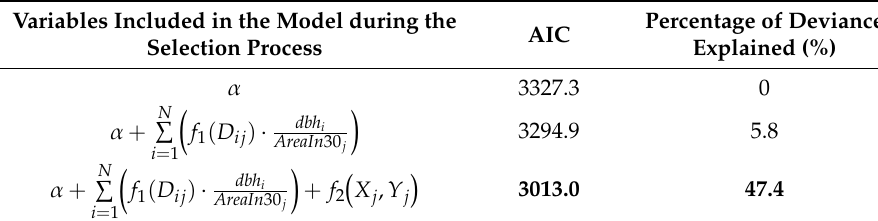
Table 2. Summary of the variable selection process according to Akaike’s Information Criterion (AIC) and the percentage of deviance explained.